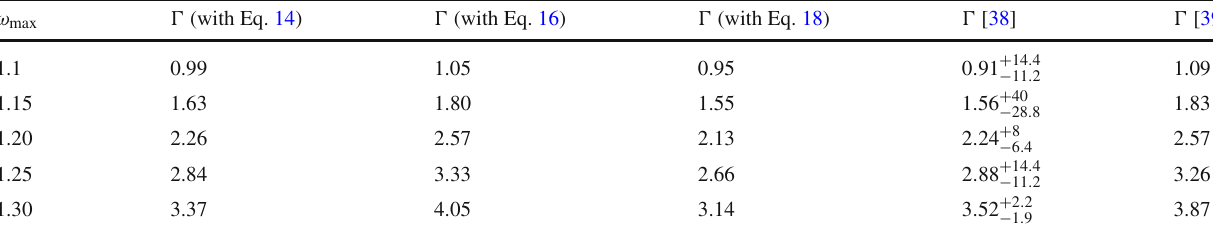
Table 4 Partial decay rates for semileptonic decay of (cid:2) b → (cid:2) c , (cid:3) (in 10 10 s − 1 ) ω (cid:3) (with Eq. max